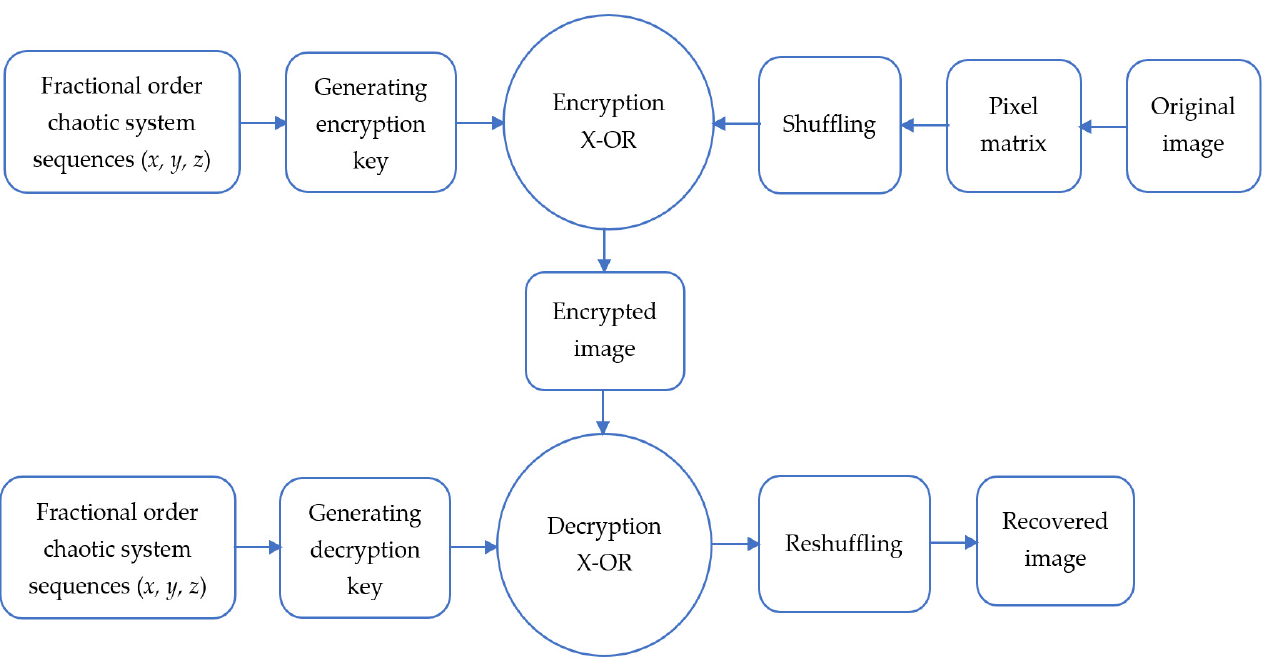
Figure 16. Image encryption and decryption block diagram based on the proposed fractional-order memristive chaotic system.